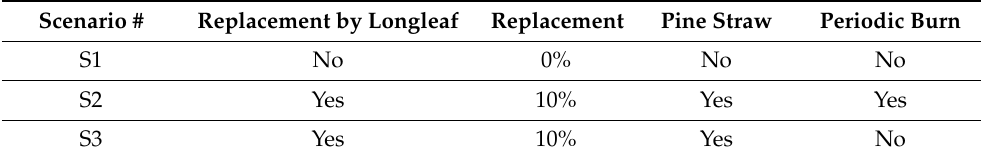
Table 1. Scenarios selected for the study.